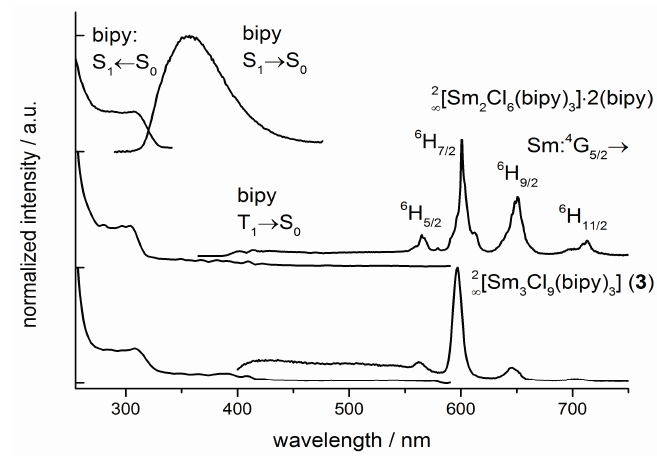
Figure 12. Photoluminescence investigation on the ligand bipy and the Sm-MOF 2 ∞ [Sm 2 Cl 6 (bipy) 3 ]·2(bipy) ( 5 ) and 2 ∞ [Sm 3 Cl 9 (bipy) 3 ] ( 9 ) in solid state at room temperature. Emission spectra were recorded at λ exc = 300 nm, excitation spectra at the maximum of the referring